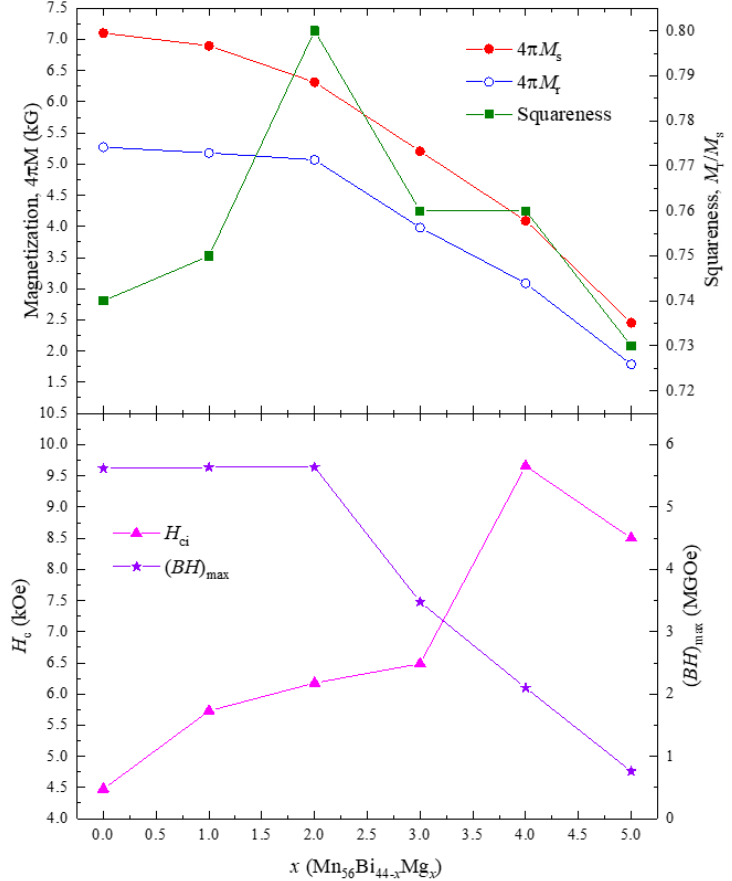
Figure 6. Composition dependence of magnetization, squareness, H c , and ( BH ) max for the Mn 56 Bi 44- x Mg x (0 ≤ x ≤ 5) bulk samples.